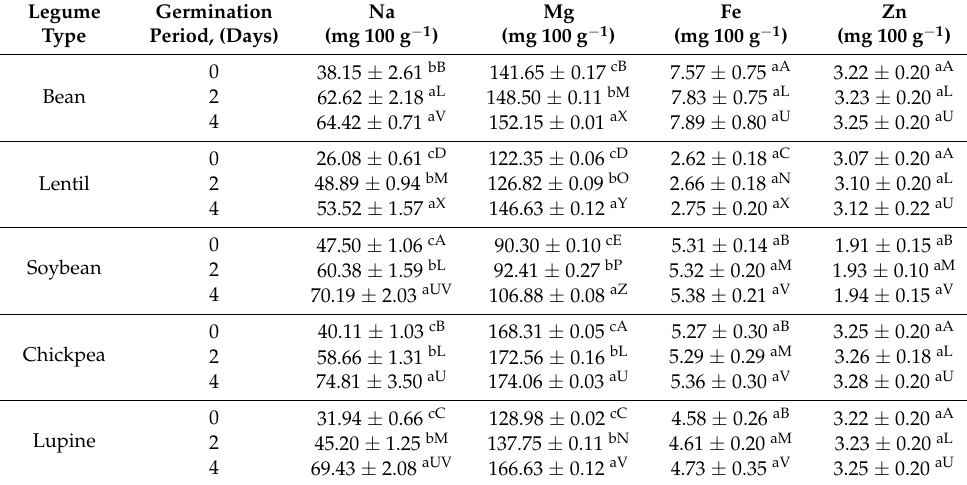
Table 2. Minerals of legumes during germination